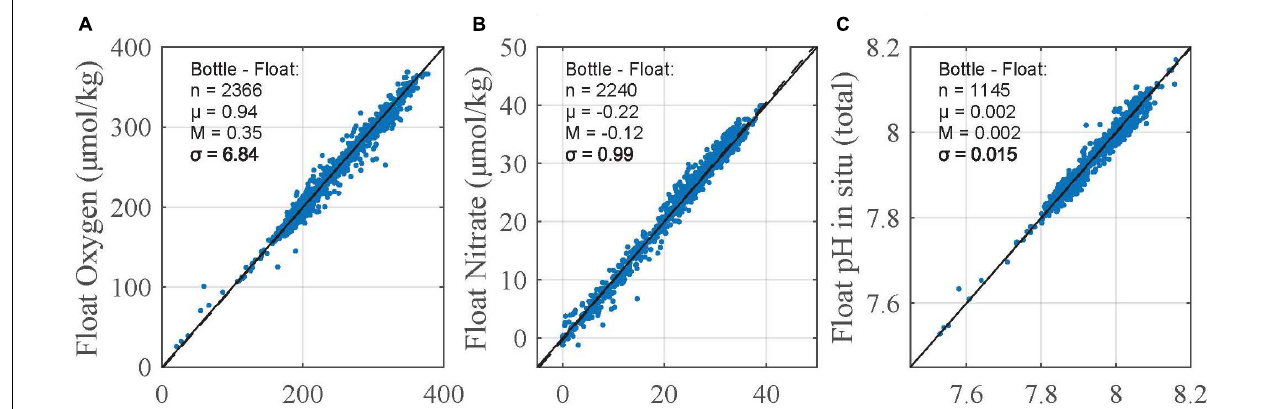
FIGURE 12 | Scatterplots of adjusted float oxygen (A) , nitrate (B) , and pH (C) data versus shipboard bottle data (all depths). The solid and dashed lines represent the 1:1 and Model II least squares fit, respectively. Bottle-minus-float statistics [number of observations ( n ), mean ( µ ), median ( M ), and standard deviation ( σ )] are included in the plots.